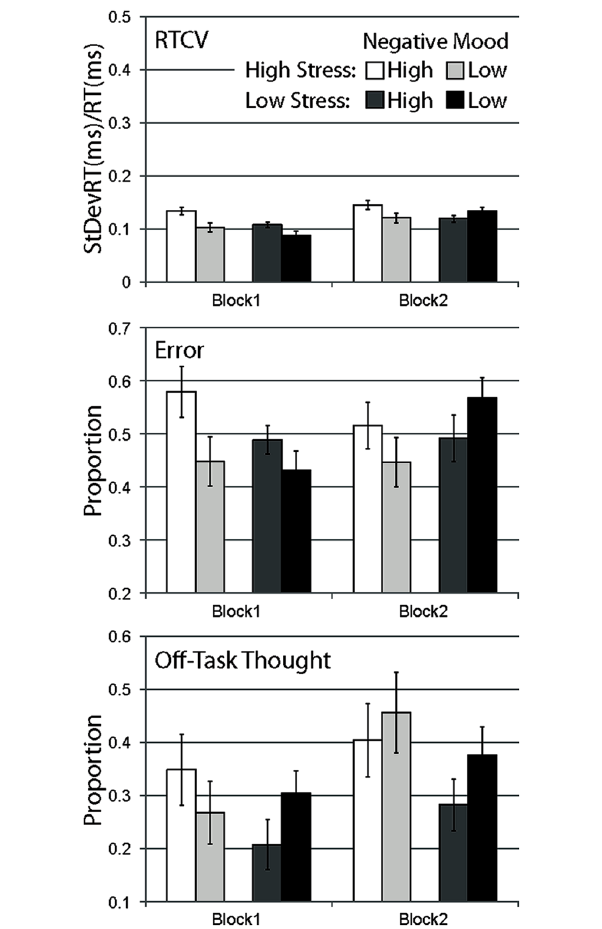
FIGURE 1 | Mean data for Experiment 1, separated by stress manipulation, negative mood group, and block. Data are shown for RTCV (reaction time coefficient of variability, calculated as reaction time standard deviation divided by the mean), error (proportion of commission errors on no-go trials), and proportion of probe trials reporting off-task thought. Error bars represent standard errors.